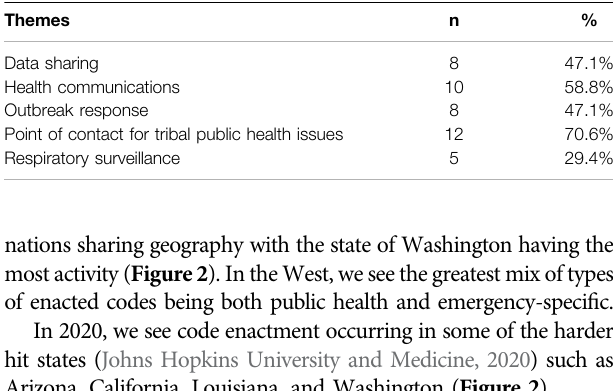
Subset of emergency preparedness (n =